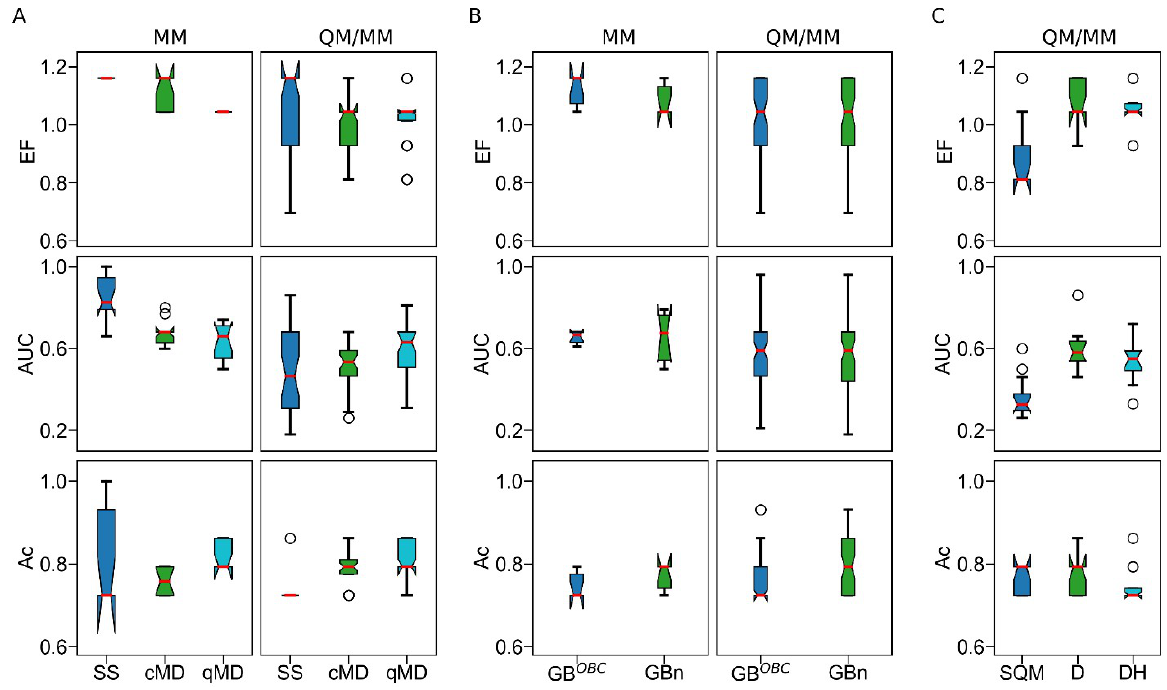
Fig 5. Effects of sampling technique (A), GB model (B), and SQM corrections (C) on the performance metrics of MM and QM/MM-GBSA methods. SQM correction impact was assessed for QM/MM-GBSA methods only. In each boxplot, red lines, notches, upper/lower whickers, upper/lower box border lines, and circles represent medians, confidence intervals of the medians, maximum/minimum values, 75/25 percentiles, and outliers, respectively.